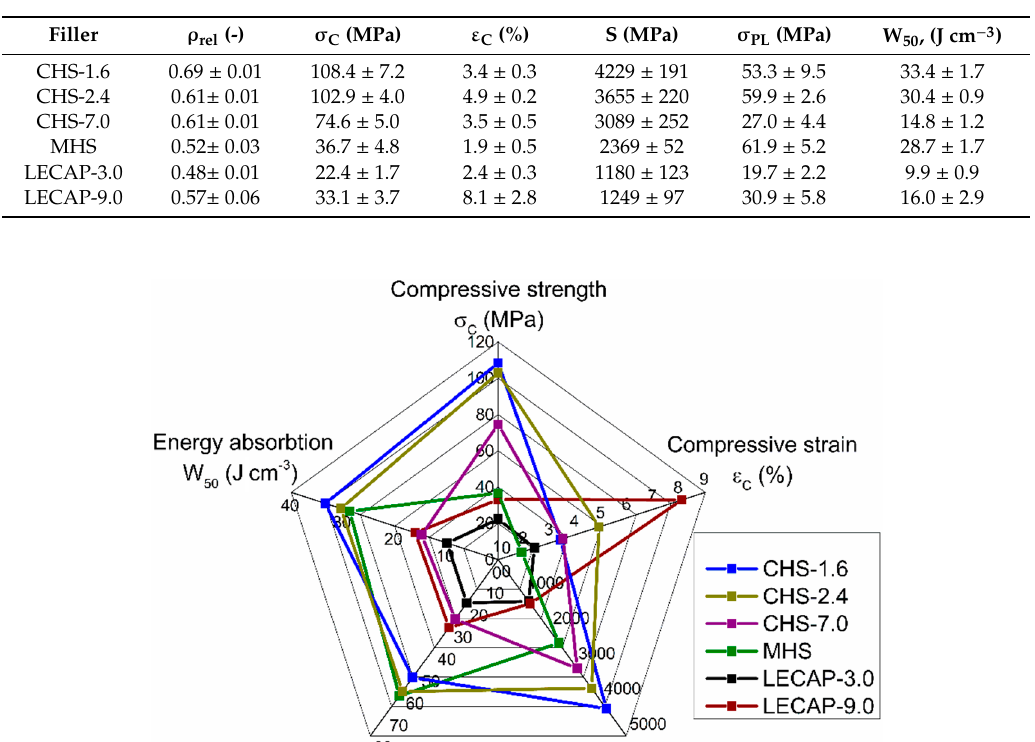
Table 6. The relative density and mechanical properties of the produced metal matrix syntactic foams (MMSFs).